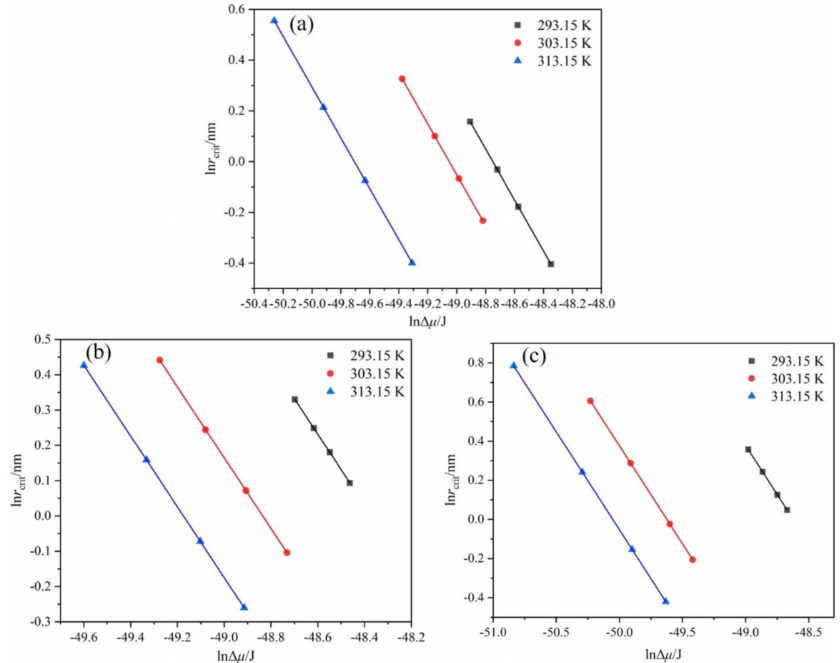
Figure 13. Relationship between ln r crit and ln ∆ µ at different T 0 : ( a ) ethanol mass fraction of 0.6, ( b ) ethanol mass fraction of 0.8, ( c ) ethanol mass fraction of